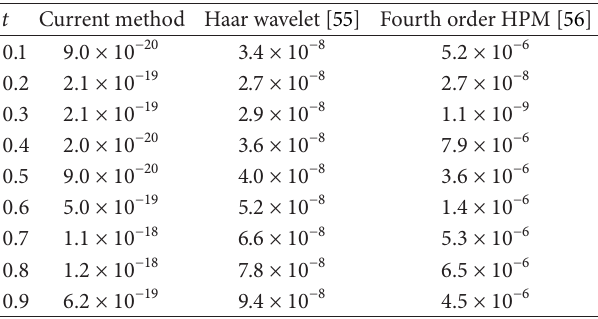
Table 5: Comparison of absolute errors between the proposed method with 𝑀 = 12 , 𝑘 = 3 , Haar wavelet method, and fourth order HPM, for different values of 𝛼 for Example 6.